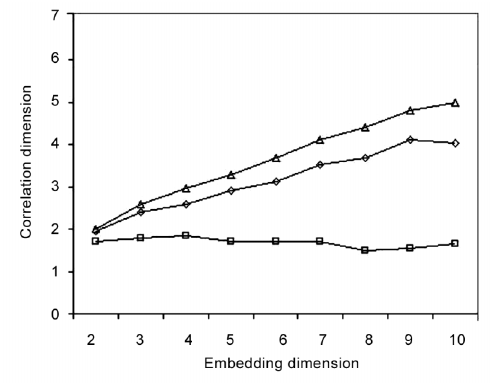
Fig. 12. Correlation dimension versus embedding dimension of inter-event time interval sequences of whole catalogue after noise reduction: diamonds – before experiments; squares – during experiments; triangles – after experiments.